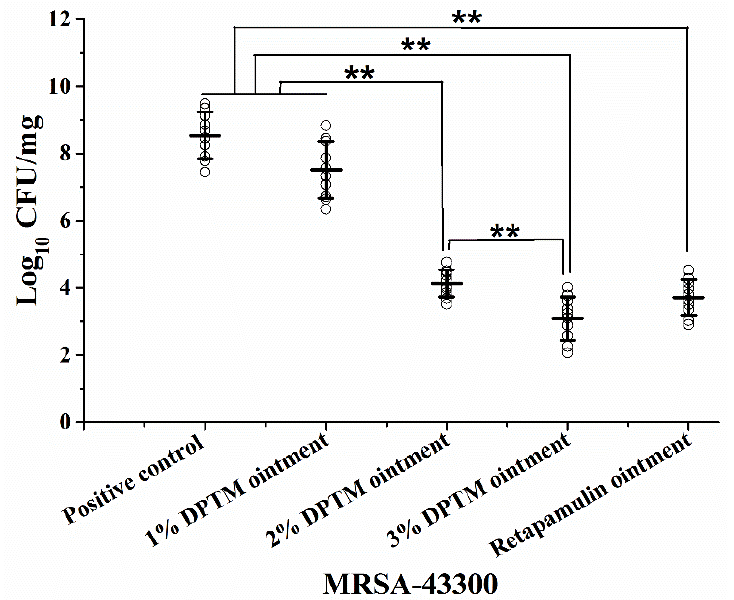
Figure 4. Efficacy of DPTM (1%, 2%, and 3% ointment) and retapamulin (2% ointment) against an experimental surgical wound infection in mice (n = 5) caused by MRSA. Values are means and standard errors of the means. * p < 0.05; ** p < 0.01.